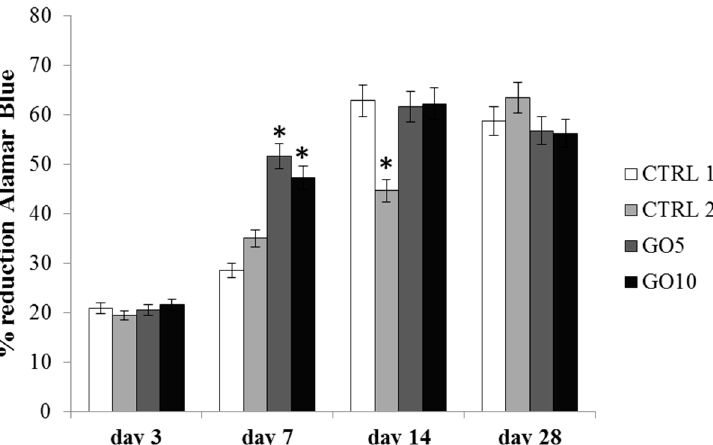
Figure 6. Alamar blue assay in DPSC cultured on bare Laminas (CTRL1), APTES-treated (CTRL2), 5 µg/mL GO-coated (GO5) and 10 µg/mL GO-coated (GO10) Laminas for 3, 7, 14, and 28 days. Forty Laminas were used for each experimental point, ten Laminas per experimental time. The histogram represents Alamar blue reduction percentage, data shown are the mean (±SD) of three separate experiments. Zero time % reduction Alamar Blue: 15.72%; * Day 7: GO5 and GO10 Laminas vs. control (CTRL1) Laminas p < 0.001; Day 14 control Laminas, GO5-coated and GO-10 coated Laminas vs. APTES-treated Laminas (CTRL2) p < 0.001.